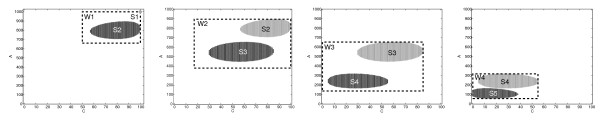
The sliding window method. In each iteration step, the window Wi captures the set Si of states in which the significant part of the probability mass is initially located (light gray), the set Si+1 of states that are reached after a time step (dark gray), as well as the states that are visited in between.